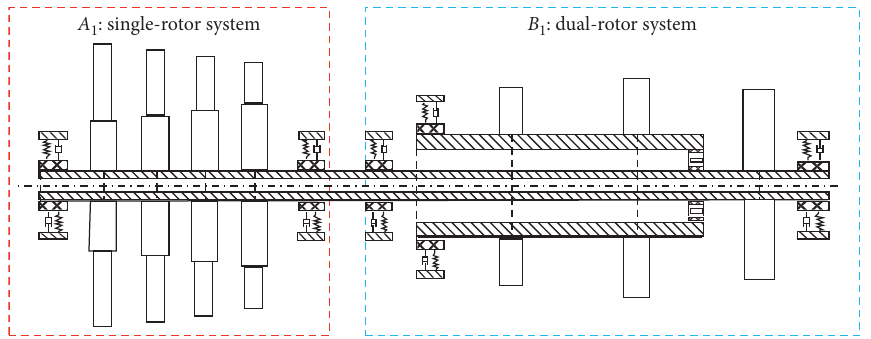
Figure 11: Dynamic model of the dual-rotor system for an